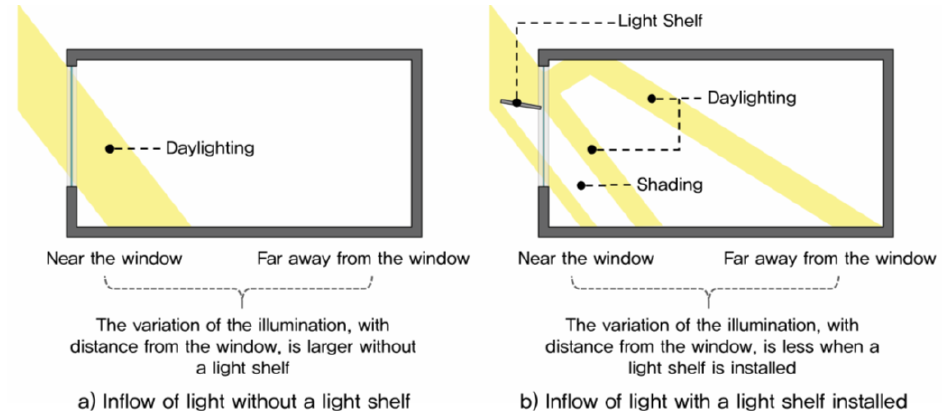
Figure 2. Inflow of light with and without a light shelf.